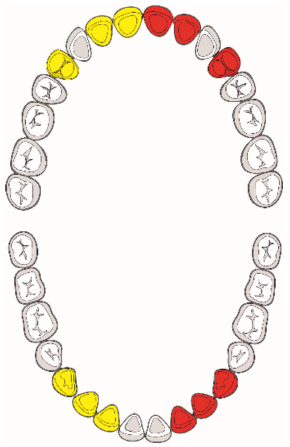
Figure 1. Teeth analyzed. Tooth selection was based on their presence on OPG radiographs. If present, teeth on the right jaw side (yellow) were analyzed; in their absence, their right counterparts (red) were selected for